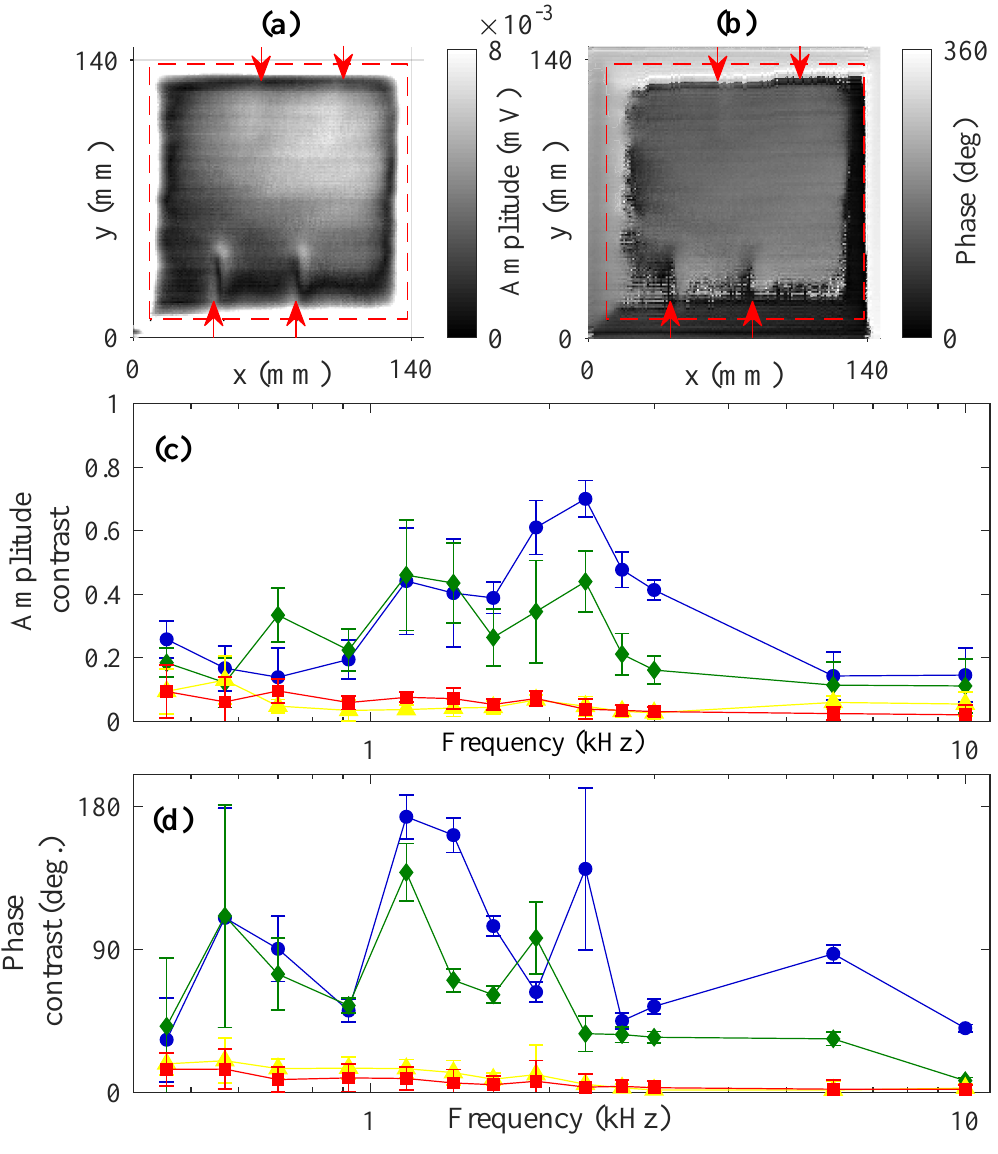
Figure 7. ( a ) amplitude and ( b ) phase change in the rf atomic magnetometer signal generated by scanning a 165.6 × 165.6 mm 2 area over a square 140 × 140 mm 2 aluminium plate with cavities that are 2mm in diameter and are drilled to a length of 40mm in the side of the plate. Plate edges are marked by dashed lines while the position of the holes is indicated by the arrows. Plots of the frequency dependence of the amplitude, C R , ( c ) and phase, C Œ , ( d ) contrast of the 0.5mm (blue dots), 1mm (green diamonds), 2mm (yellow triangles), and 3mm (red squares) deep cavities with changing